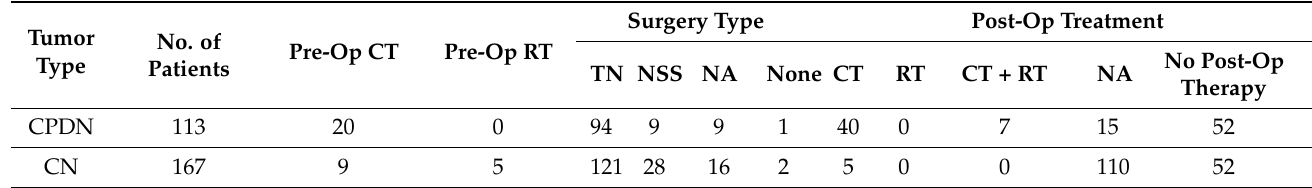
Table 2. Summary of described therapy of cystic renal tumor